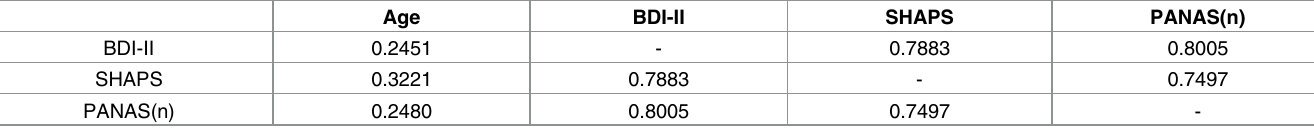
Table 2. The Pearson’s correlation coefficients between the clinical measuresand the subjects’ age